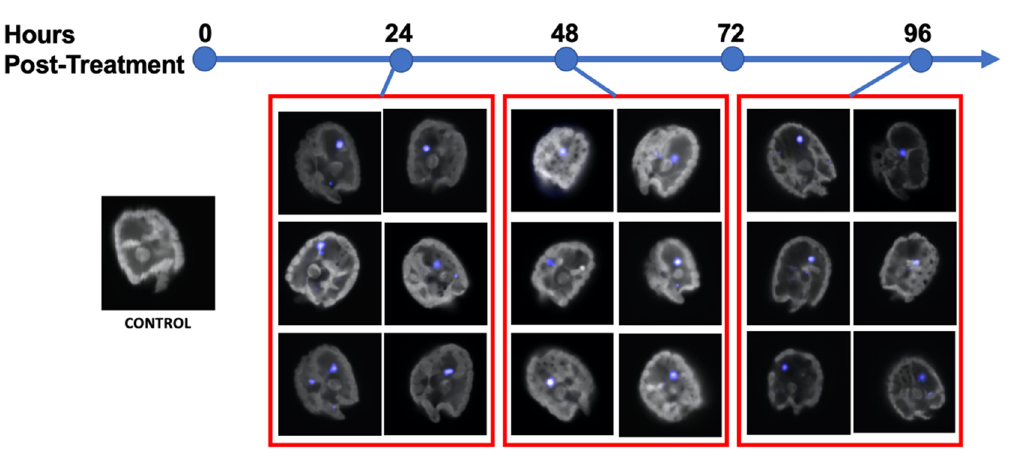
Figure 3. Confocal images of Amphidinium carterae . A control cell with no antisense morpholino introduced is on the far left. Red boxes encompass images of cells from a culture with Endo Porter and antisense-morpholino, fluorescently tagged with Lissamine (593 nm, pseudo-blue) at 24-, 48- and 96-h post-treatment. The grey areas are the auto-fluorescence emitted within 720–759 nm.